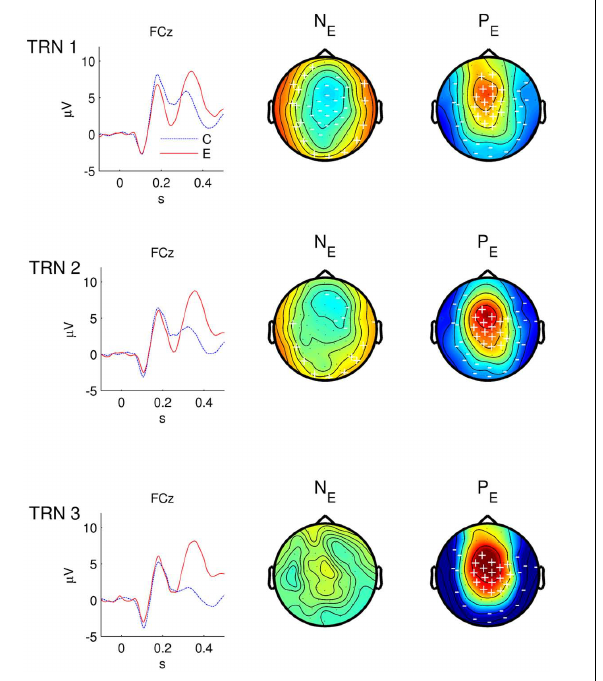
FIGURE 7 |Average event-related potentials for feedback-related activity. Trace plots indicate average voltage (in μ V) over time at FCz/8; correct classification = C (blue, dotted line), error classification = E (red, solid line). Symbols plotted on the topographical plots indicate membership within a statistically significant negative cluster (“ − ”) or positive cluster (“ + ”) of electrodes.